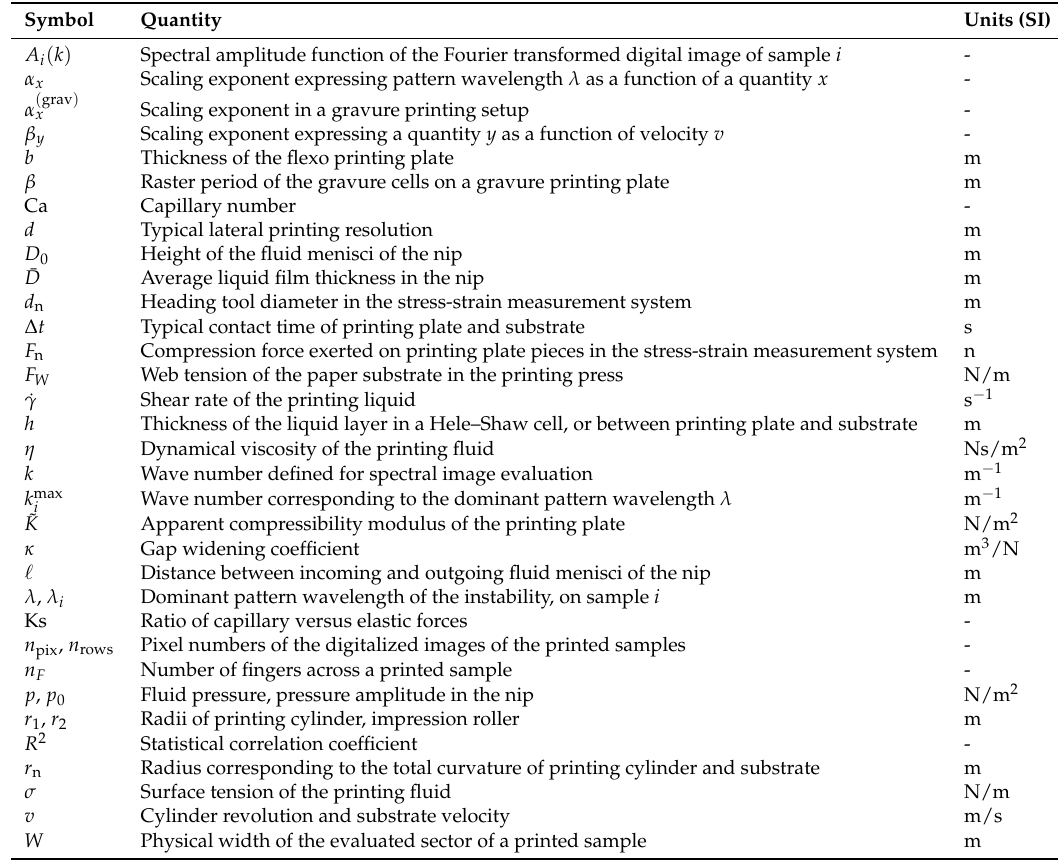
Table A1. List of symbols. In the text, physical parameters are sometimes given in derived units (e.g., mm and